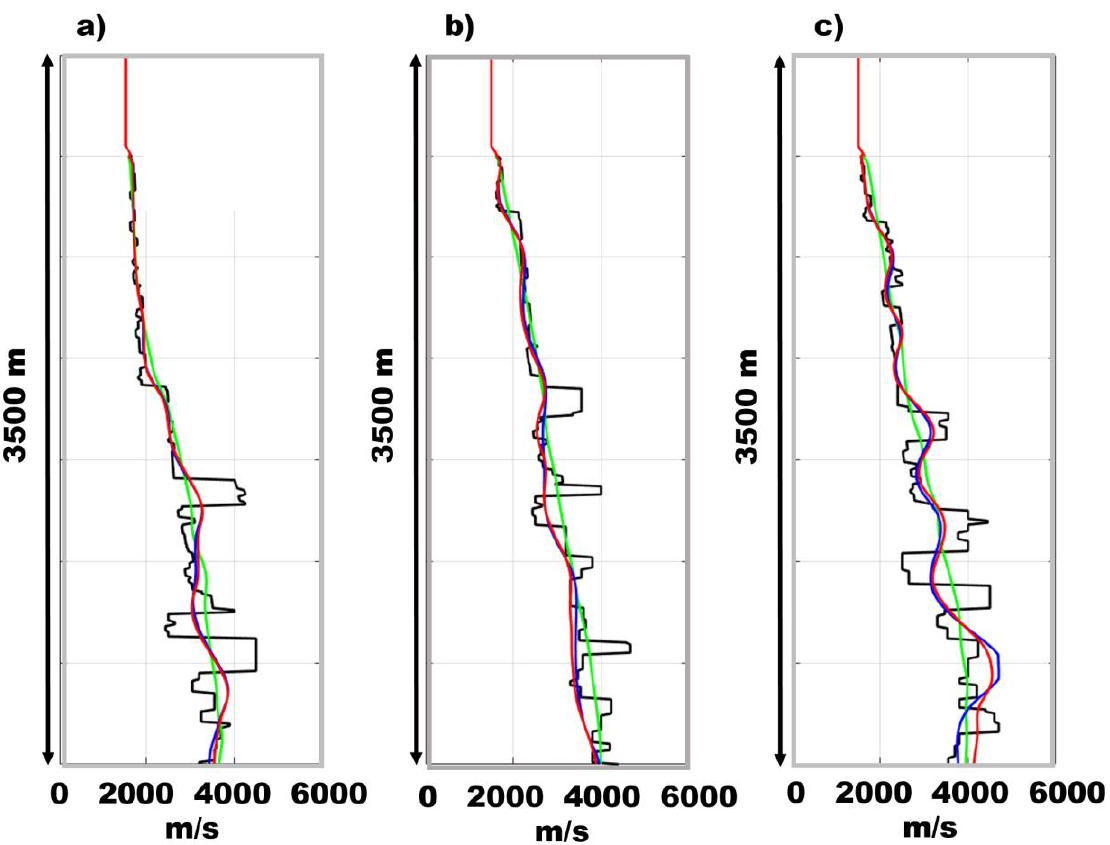
Figure 6. Vertical velocity profiles for various lateral coordinates and various inversion scenarios for a frequency of 3 Hz, black represents the true speed model, green — starting model, blue — classic FWI, and red — asymptotic FWI: ( a ) x = 2000 m; ( b ) x = 5000 m; ( c ) x = 8000 m.